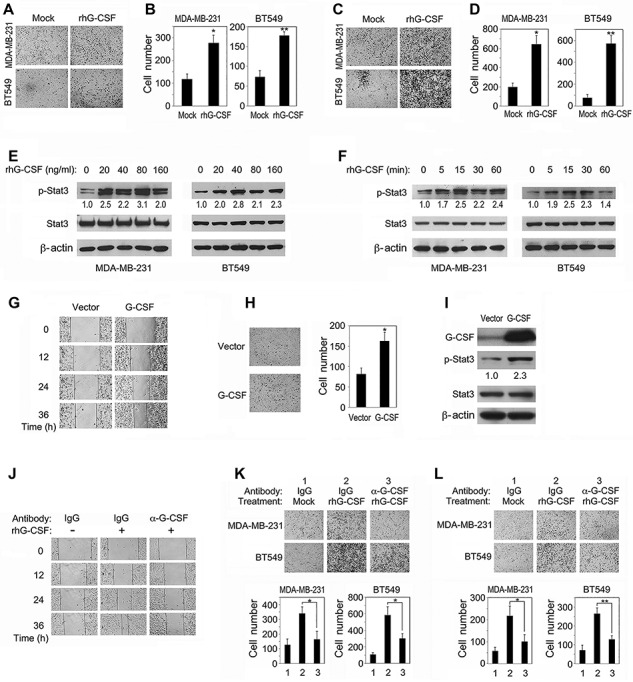
rhG-CSF promotes TNBC cell migration and invasion by activating Stat3. (A–D) MDA-MB-231 and BT549 cells cultured in the upper chambers in transwells were treated with or without 20 ng/ml rhG-CSF in DMEM containing 0.2% FBS for 24 h and subjected to migration (A and B) and transwell matrigel invasion (C and D) assays. (E and F) MDA-MD-231 or BT549 cells were treated with different concentrations of rhG-CSF in serum-free DMEM (E) or 20 ng/ml rhG-CSF for varying time periods (F) and examined for p-Stat3 protein levels. (G–I) Stable expression of G-CSF in MDA-MB-231 cells enhances their migratory (G) and invasive (H) capabilities and activates Stat3 signaling (I). (J–L) MDA-MD-231 cells treated with 20 ng/ml rhG-CSF in the presence of anti-G-CSF antibody or lgG were subjected to wound healing (J), transwell migration (K), and invasion (L) assays. Typical microscopic fields and blots are shown and quantitative data are presented as mean ± SD from at least three independent experiments. *P < 0.05, **P < 0.01.